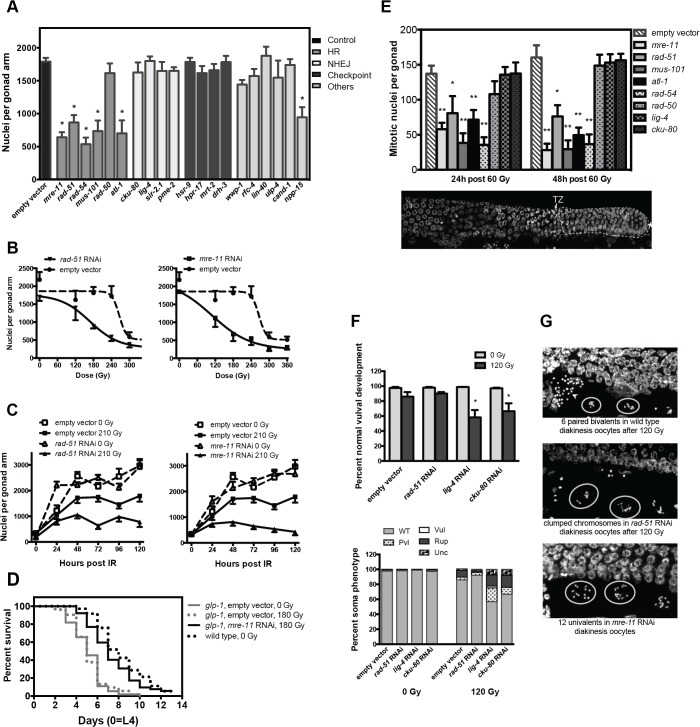
Radiation sensitivity of germline tumor after RNAi.(A) Knockdown of HDR ortholog genes radiosensitizes ar202 tumors. L4 ar202 worms were irradiated at 210Gy, an ineffective dose in this strain as shown in Fig 3B, and germline nuclei were quantitated at 72h post irradiation. Genes knocked down are classified according to their function in DNA damage repair pathways. Asterisks indicate significantly increased radiation sensitivity compared with empty vector control group, *p<0.01. (B) Inactivation of rad-51 (left) or mre-11 (right) enhances radiosensitivity of germ cells. L4 ar202 worms were irradiated and germline nuclei counted 72h post radiation. Data (mean±s.e.m) are from 5–8 worms⁄group. Note the empty vector data set is the same in left and right panel. (C) Time course of germ cell accumulation after 210Gy combined with rad-51 RNAi (left) or mre-11 RNAi (right). Data (mean±s.e.m) are from 7–12 worms⁄group. Note the empty vector data set is the same in left and right panel. (D) mre-11 inactivation extends survival of glp-1(ar202) after 180Gy treatment of L4 larvae. Survival assays were performed at 25°C. Data are from one representative of 3 experiments scoring ≥50 animals per group. (E) Knockdown of HDR genes radiosensitizes mitotic germ cells in distal gonad of wild-type worms. L4 stage-worms were irradiated with 60Gy and mitotic germ cells were quantified as in Fig 1A. Mitotic germ cells reside between the distal end of the gonad (indicated by bold asterisk in bottom panel) and the transition zone [10], which characteristically contains crescent-shaped nuclei (arrow). *p<0.05 and **p<0.01 vs. empty vector control. (F) Knockdown of NHEJ genes results in vulval abnormalities post irradiation. Phenotypes were evaluated 120h post 120Gy using 75–85 worms⁄group. Somatic developmental phenotypes were quantified as wild-type vulva (WT), protruding vulva (Pvl), vulvaless (Vul), ruptured vulva (Rup) and uncoordinated (Unc). *p<0.05. (G) Knockdown of HDR genes in wild-type worms results in highly-abnormal oocyte chromosome morphology post irradiation. Chromosome morphology was quantified in the two oocytes (circled) closest to the spermatheca (arrow in right upper panel) at 18h post irradiation. Quantification of these data is included in Table 2.